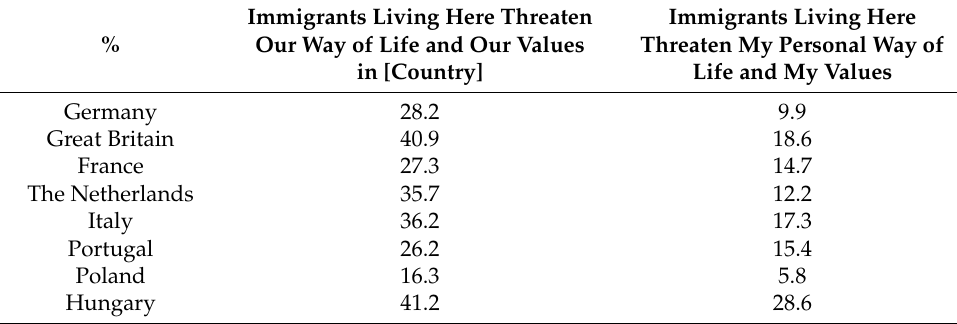
Table 1. Research on immigrants and way of life and